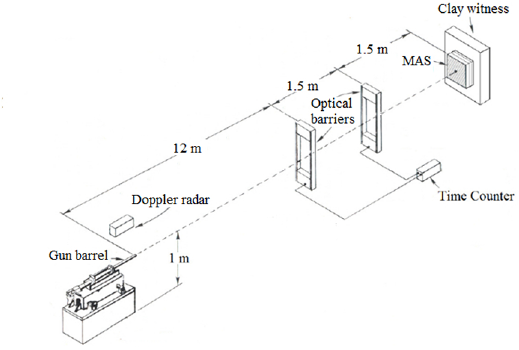
Figure 4. Schematic view of the ballistic test arrangement 17 (adapted).